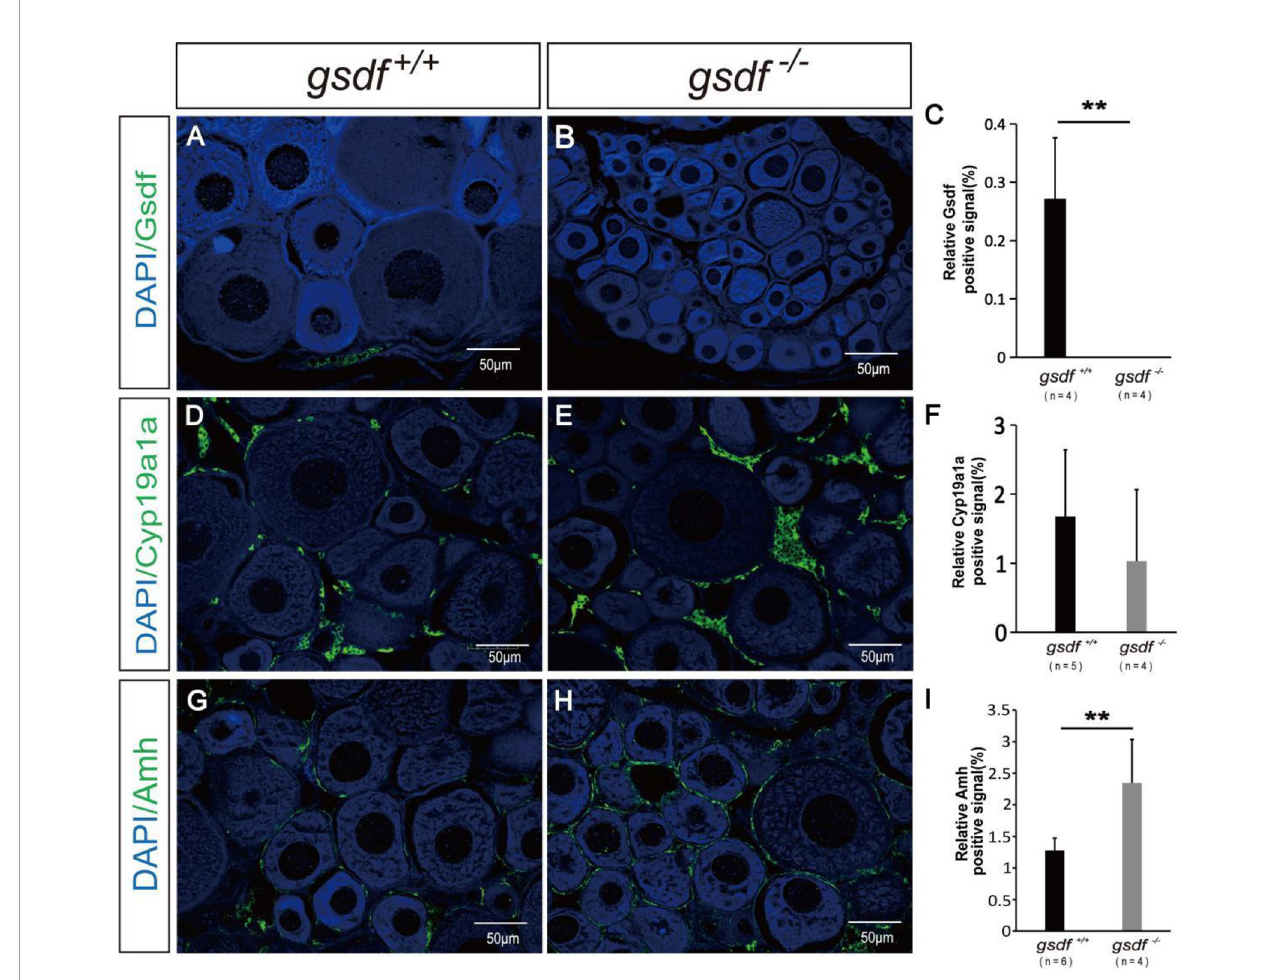
FIGURE 3 | Immuno fl uorescence analysis of Gsdf, Cyp19a1a and Amh in ovaries of XX gsdf -/- and gsdf +/+ tilapia at 6 mah. Gsdf (A, B) , Cyp19a1a (D, E) and Amh (G, H) . Green fl uorescence represents positive signal. Blue fl uorescence represents the DAPI signal. The statistical analysis of the positive signal intensity (C, F, I) . Results are presented as mean ± SD. ** indicates signi fi cant difference at P <